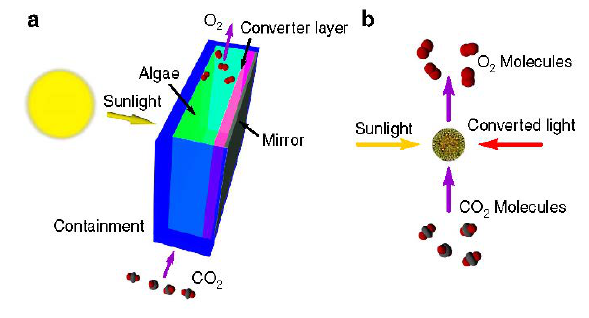
Figure 10: (a) Flat panel algal bioreactor with PL back-side converter coated with red-emitting phosphor Ca 0.59 Sr 0.40 Eu 0.01 S. (b) Both CO 2 -to-biomass conversion and oxygen production rate were shown to be increased by shifting the light